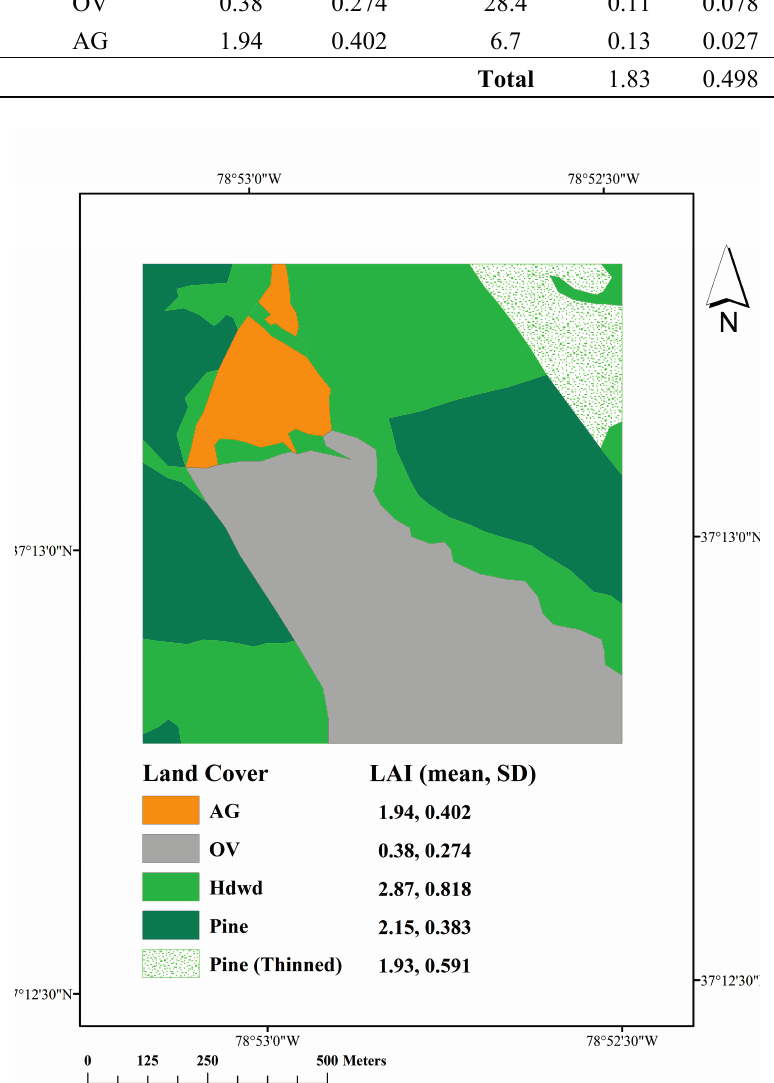
Figure 9. EPA_Appomattox LAI-RM (23 May